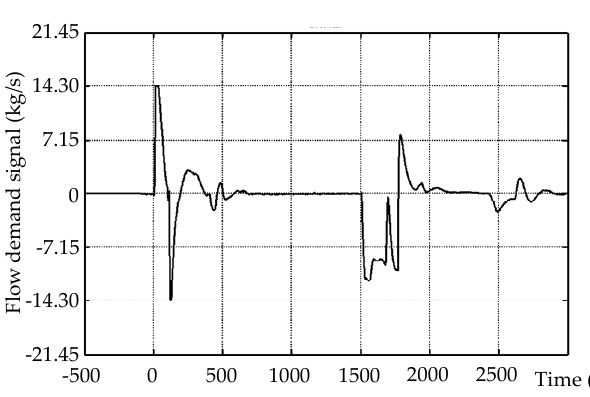
Figure 15. DMC supplementary air flow demand of 1000 MW plant.